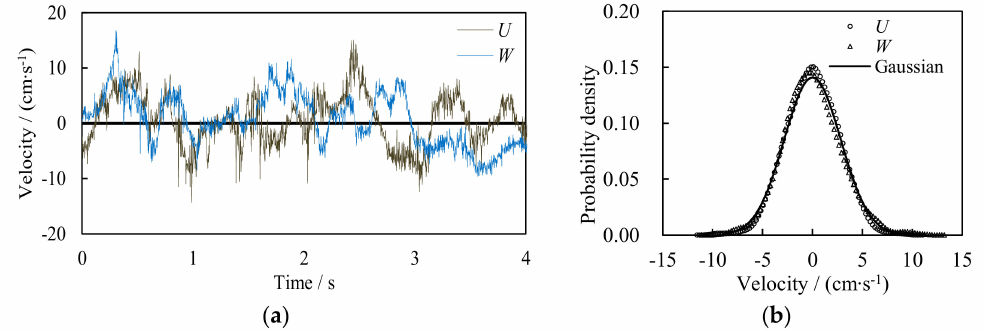
Figure 3. Measured flow velocity of one point: ( a ) instantaneous velocity; ( b ) probability density.